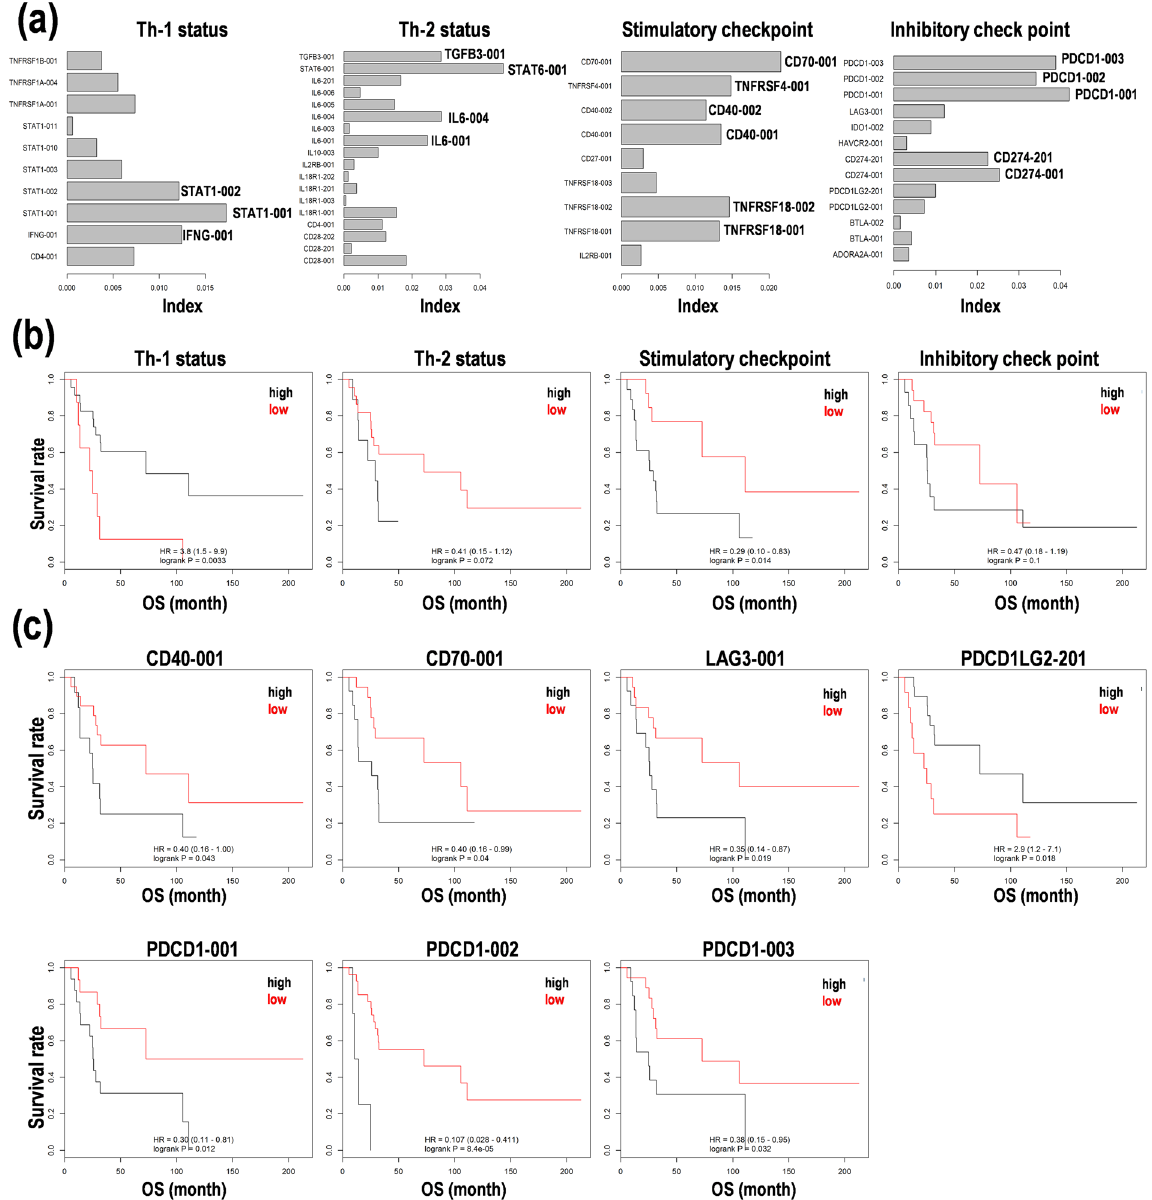
Figure 2. Survival prediction based on T helper cell type 1/2 (Th-1/Th-2) status and immune checkpoint activity in primary central nervous system lymphoma (PCNSL). ( a ) Index calculated from combined methods of random survival forests analysis and principal component analysis (PCA). ( b ) Kaplan-Meier analysis on the survival prediction formula in 31 patients with PCNSL. The patients were divided into two subgroups with high (black line) and low (red line) scores from the median score calculated based on the formula. ( c ) Kaplan-Meier analysis of the expression levels of representative genes for immune checkpoint. CD40 and CD70 as stimulatory checkpoint genes. Lymphocyte activation gene 3 (LAG3), programmed cell death ligand 2 (PDCD1LG2), and programmed cell death 1 (PDCD1) as inhibitory checkpoint genes. The patients were divided into two subgroups with high (black line) and low (red line) expression by the median expression of the gene. Hazard ratio (HR) with 95% confidence interval (CI) and p -value from log rank test were calculated. OS; overall